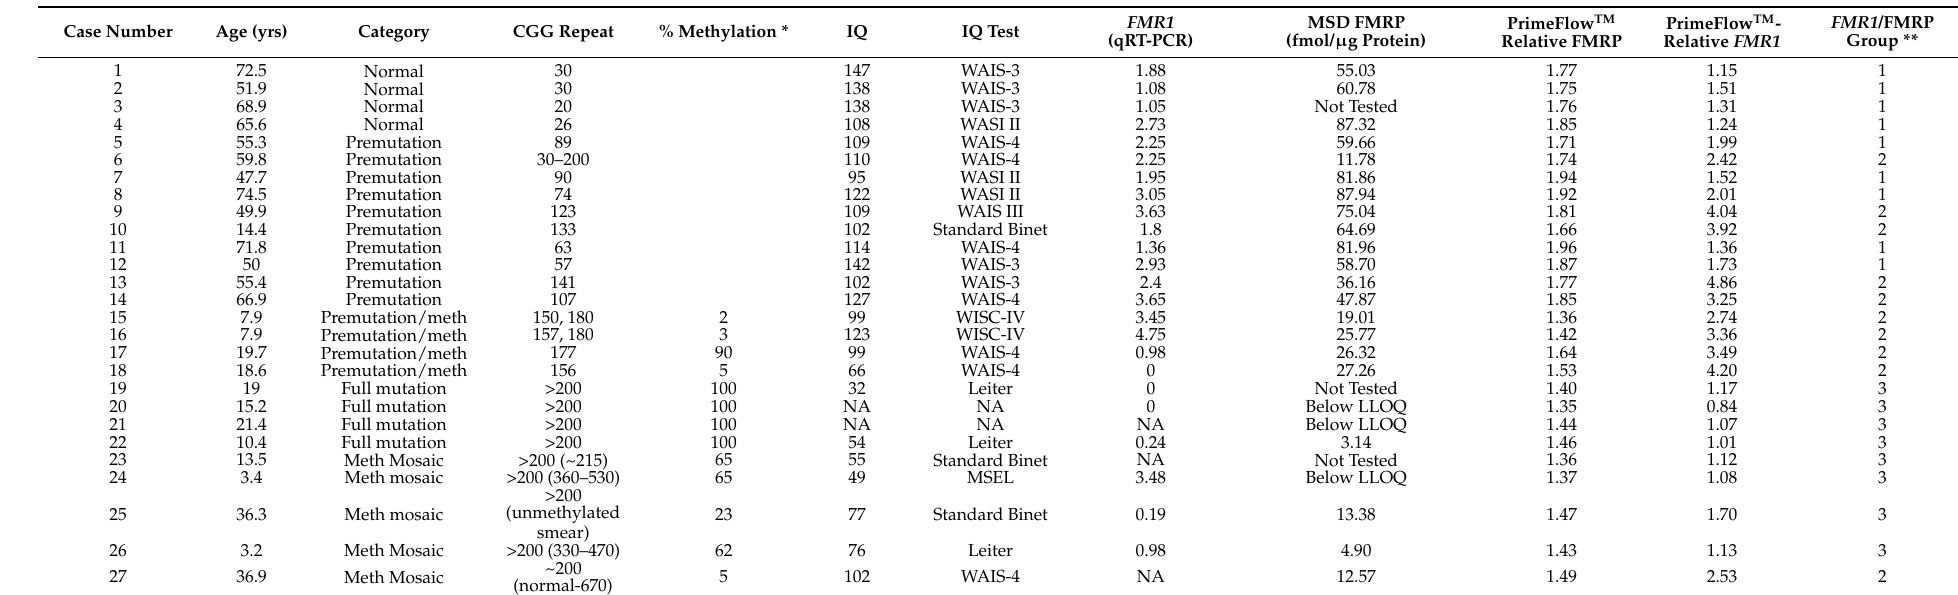
Table 1. Study Participants and Measurements